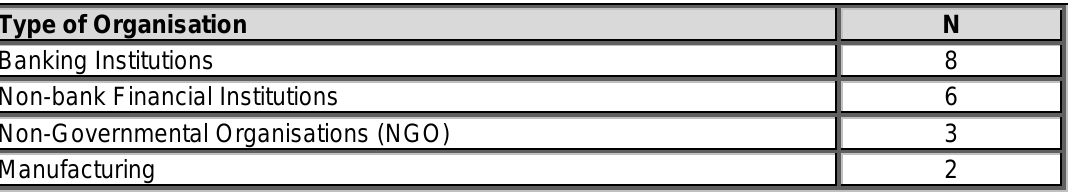
Table 1: Sample of